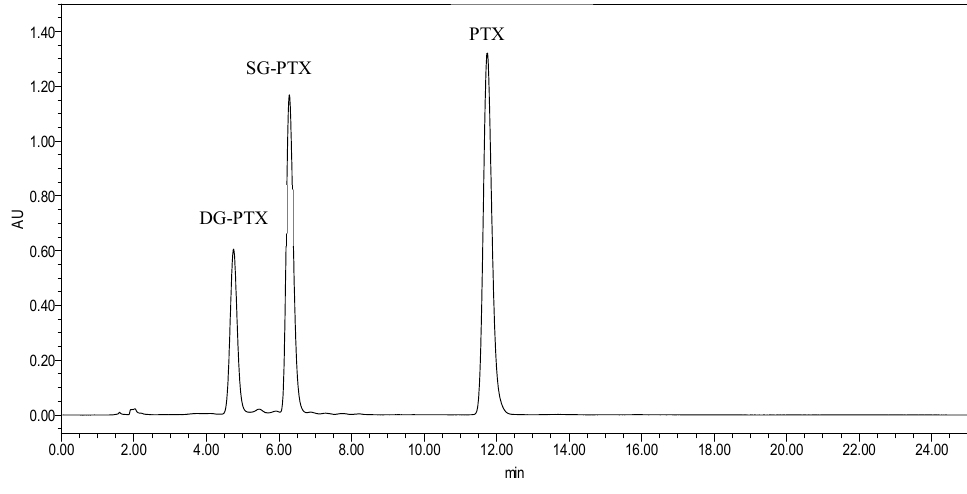
Figure 2. HPLC chromatography of PTX, SG-PTX, and DG-PTX.